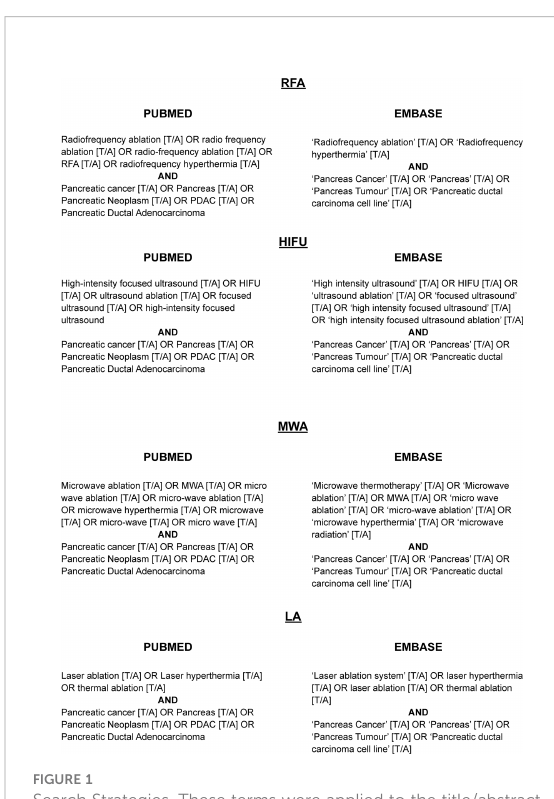
FIGURE 1 Search Strategies. These terms were applied to the title/abstract of texts in each database for each thermal technique.